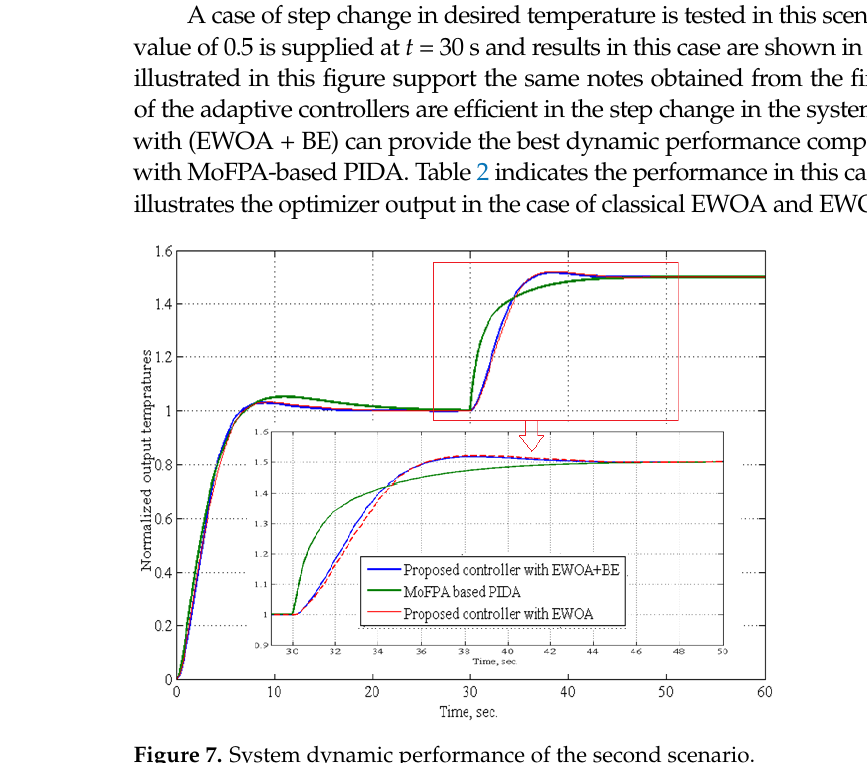
Table 2. Performance specification due to second case.